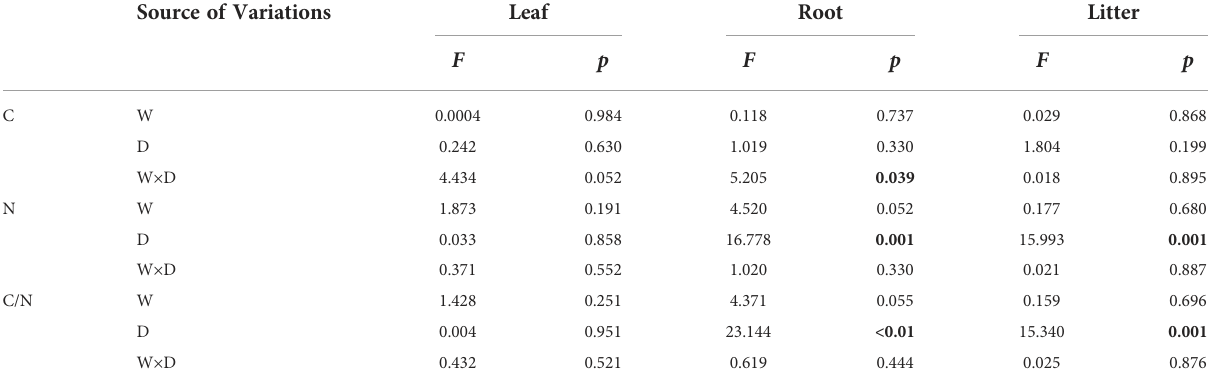
TABLE 1 Repeated measures analysis of variance (ANOVA) of C and N concentrations and C/N ratios in leaves, roots, and litter of C. lanceolata . Source of Variations Leaf Root